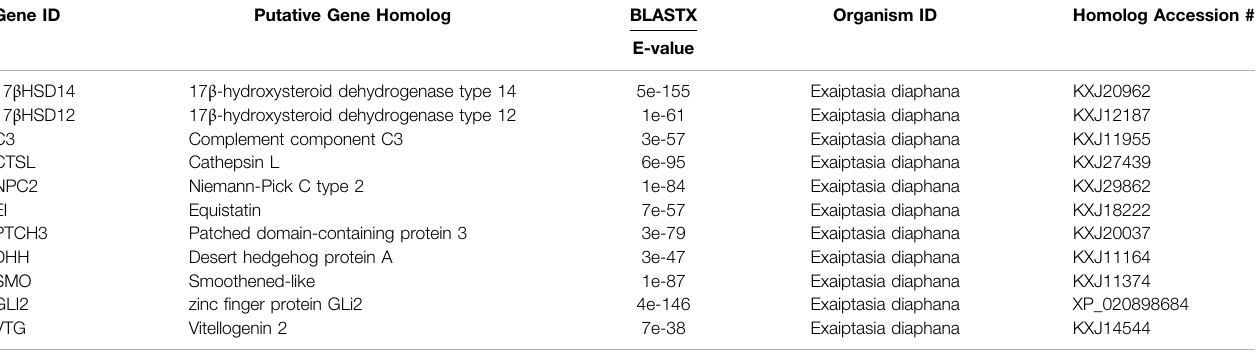
TABLE 1 | BLAST results for RDA probes. Searches performed at NCBI using BLASTX algorithm and the non-redundant database (nr) with default search parameters.